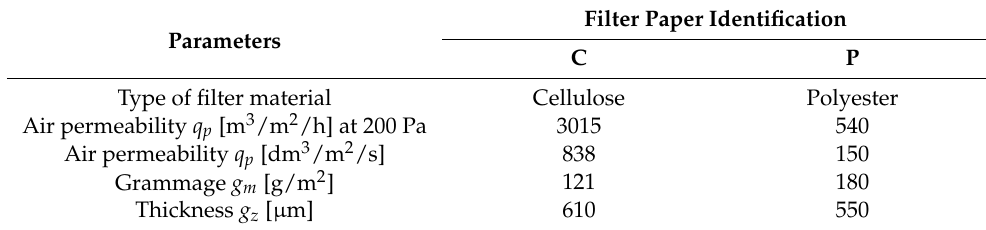
Table 1. Parameters of the structure of the tested filter materials given by the manufacturer. Filter Paper Identification Parameters Parameters C P